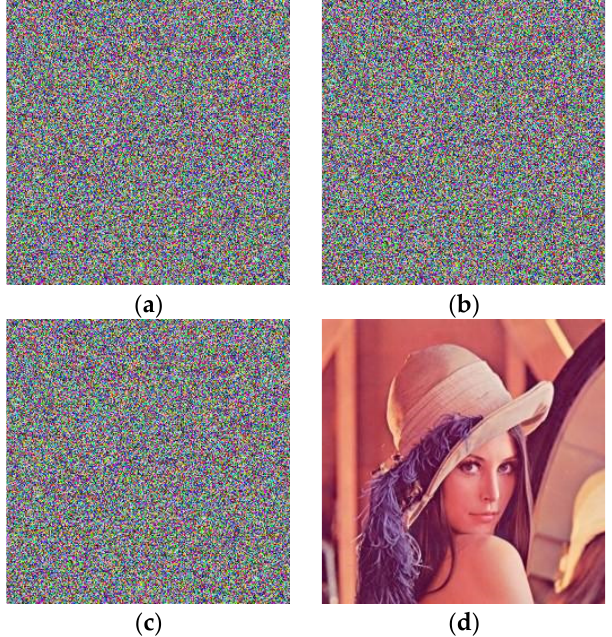
Figure 12. Sensitivity experiment. ( a ) Changes the hash value; ( b ) changes the n of the T matrix and decrypts the image of the n , i ; ( c ) changes the decryption image of the Huffman replacement rule; and ( d ) the correct key decryption.